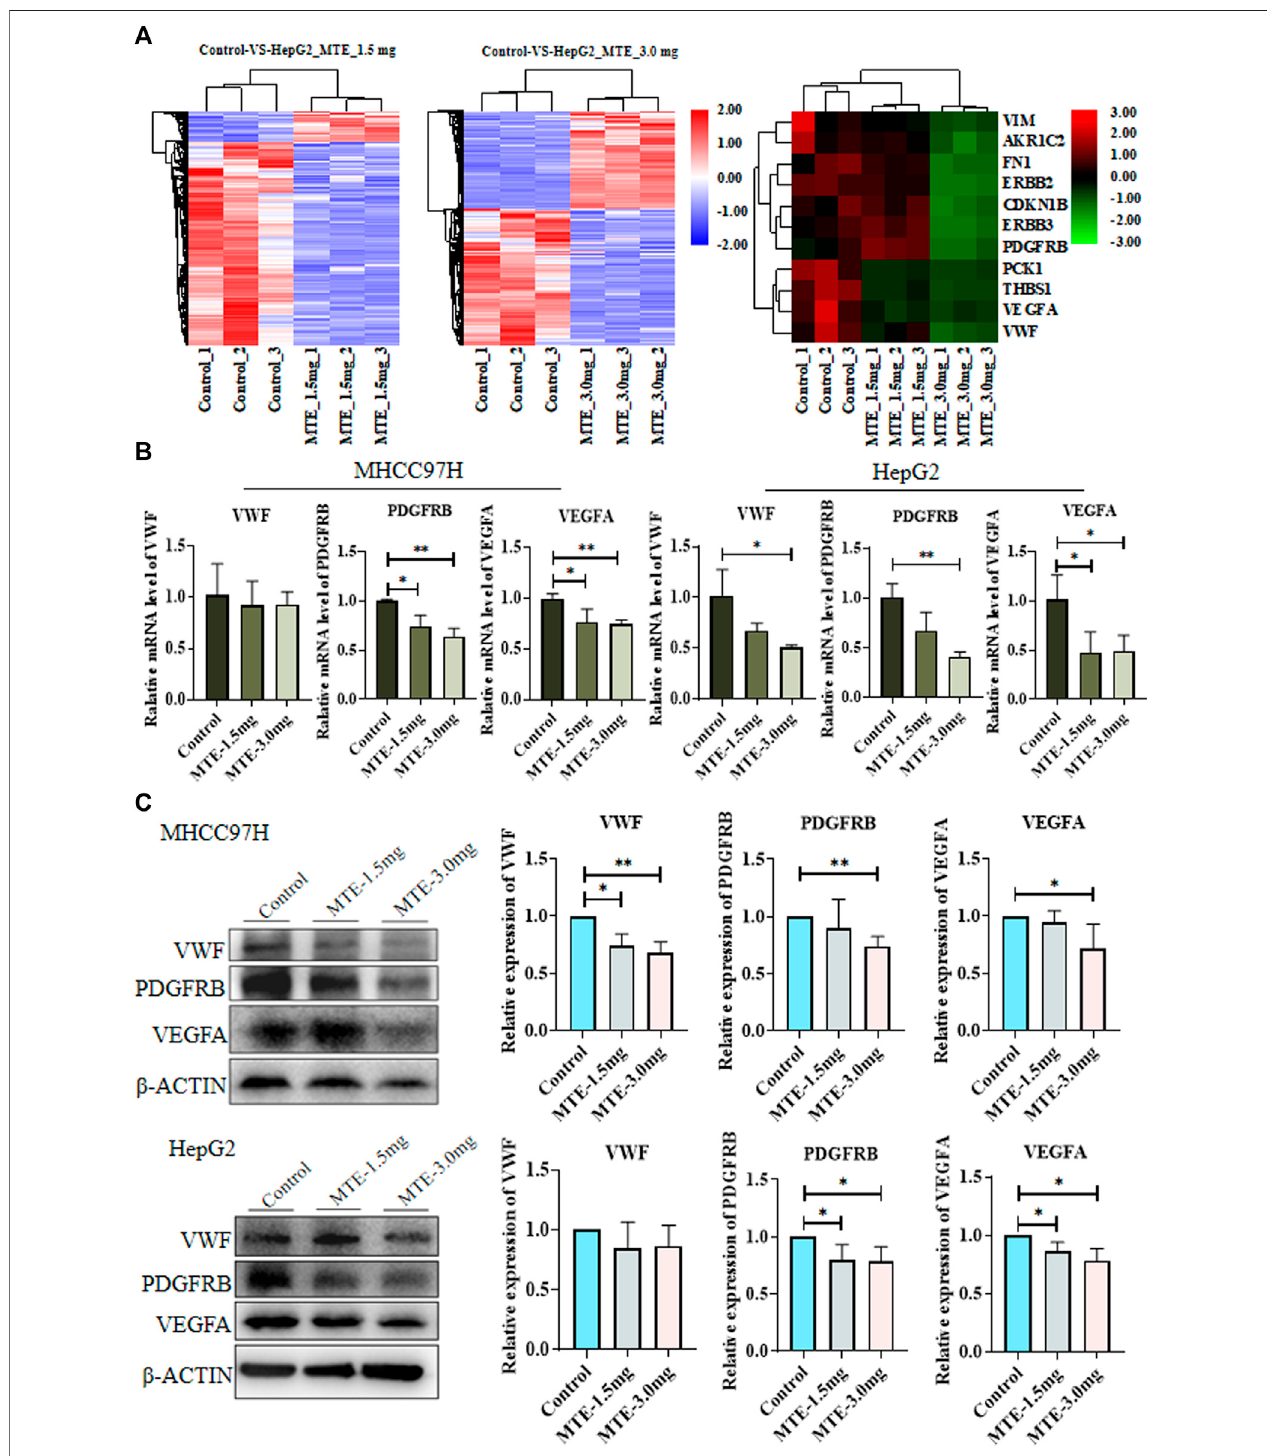
FIGURE 2 | Identi fi cation and veri fi cation of differentially expressed genes (DEGs) between HCC cells treated with or without MTE. (A) HepG2 cells were treated with vehicle, 1.5 mg/ml MTE, or 3.0 mg/ml MTE for 24 h and subjected to RNA-sequencing. The clustering ofdifferentially expressed genes of control vs. MTE-1.5 mg/ ml and control vs. MTE-3.0 mg/ml was presented. The DEGs associated with metabolism and angiogenesis were clustered. (B) mRNA expression levels of VWF, VEGFR, and PDGFRB in MHCC97H and HepG2 cells treated with or without MTE. (C) Protein levels of VWF, VEGFR, and PDGFRB in HCC cells treated with or without MTE. * p < 0.05; ** p < 0.01.